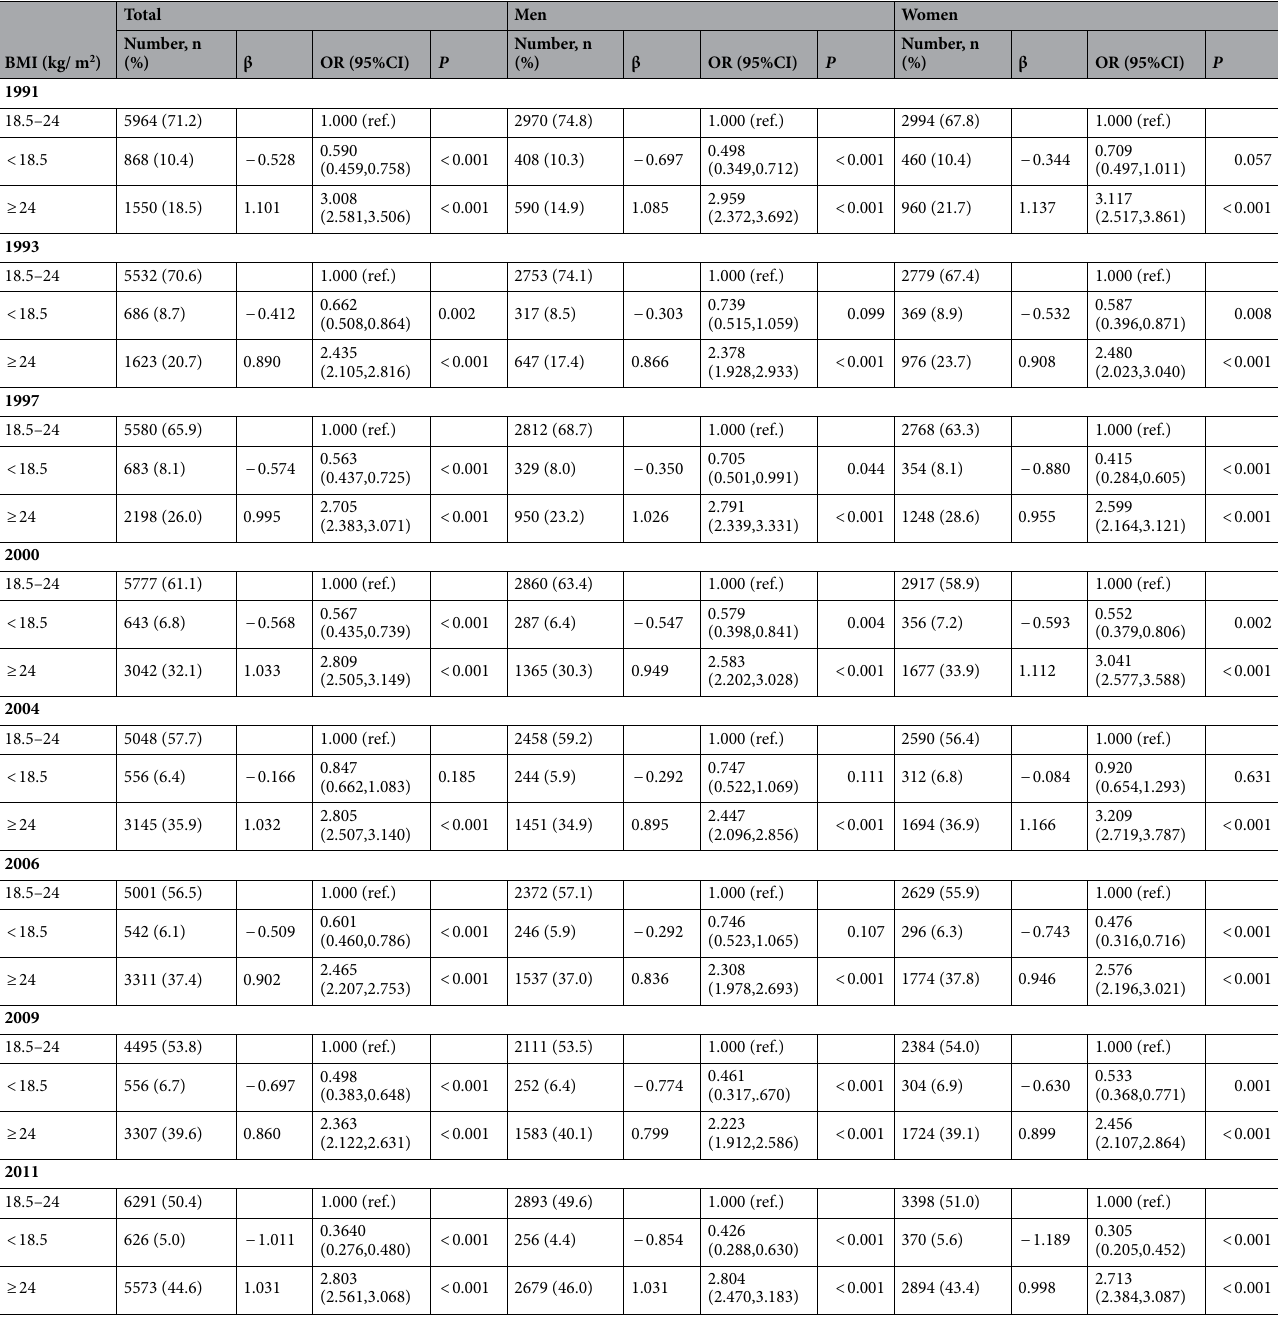
Table 2. Associations of overweight and obese with prevalent hypertension. Adjusted for age, current smoking and current drinking. BMI Body mass